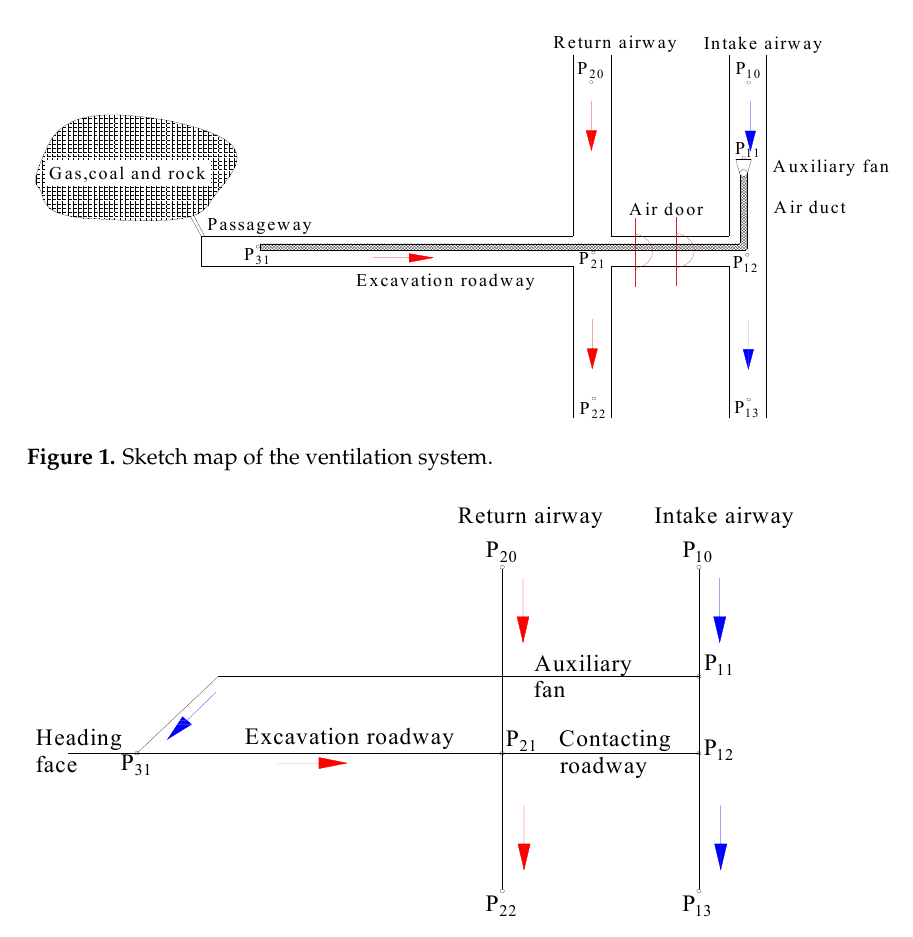
Figure 2. Diagram of the simplified ventilation network in a general ventilation system.